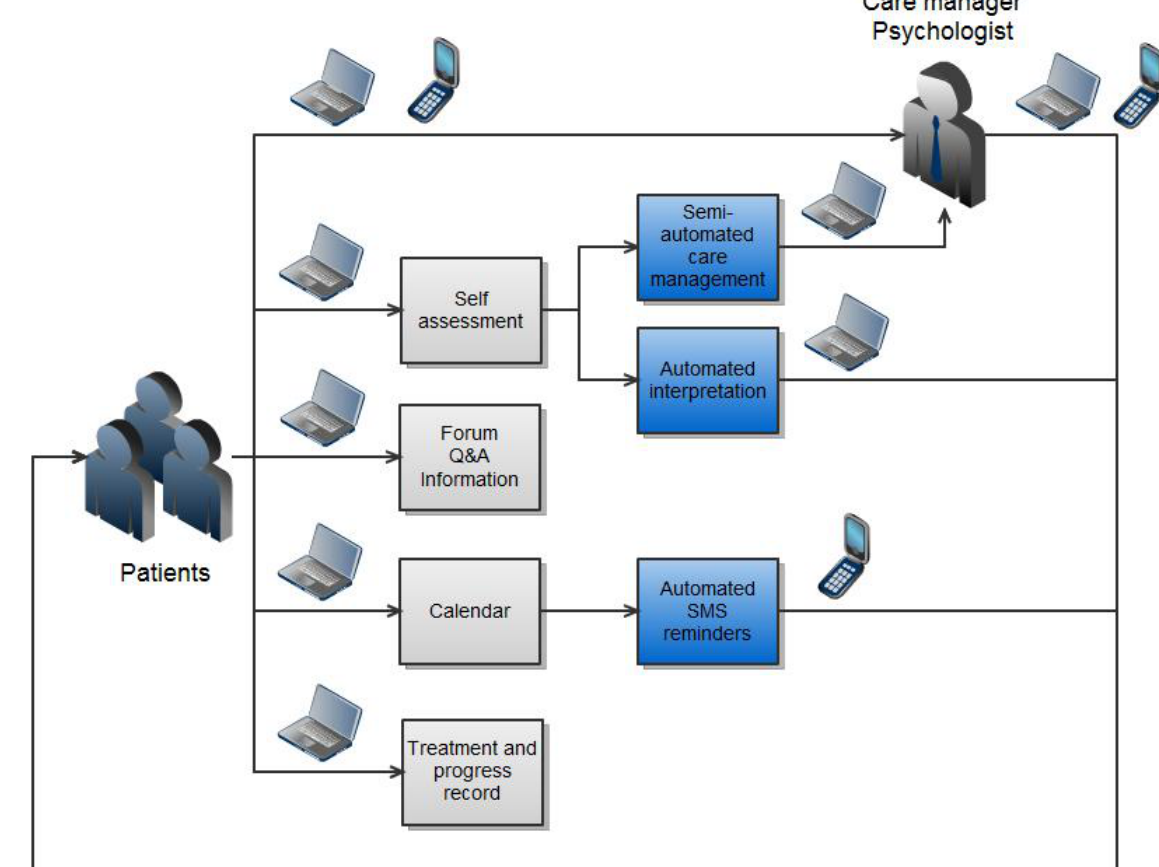
Figure 1. Simplified patient view of the intervention in which arrows describe the direction of information flow, boxes represent ICT system functionalities, and icons above arrows denote available channels (personal computer, mobile